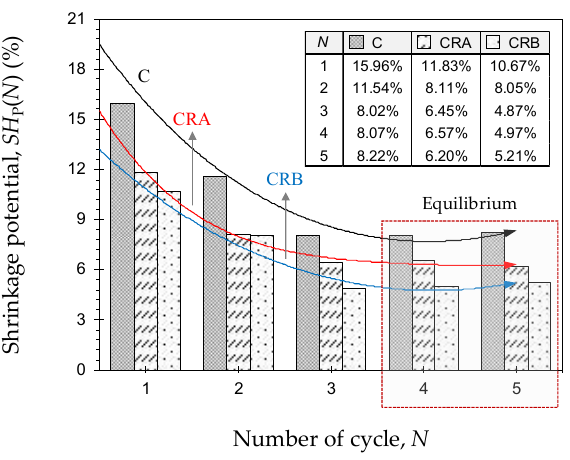
Figure 6. Variations of shrinkage potential against the number of applied cycles for the tested samples.